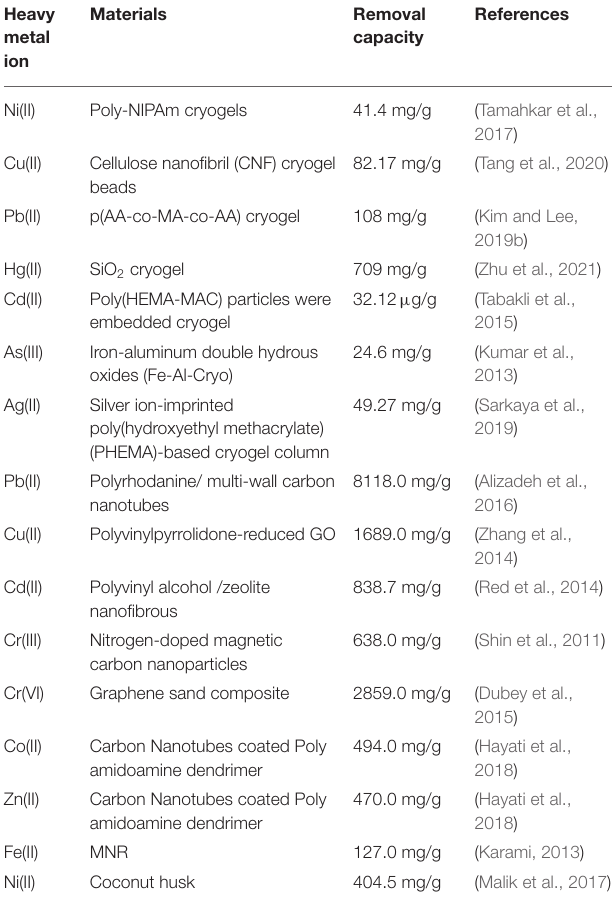
TABLE 3 | Comparison of heavy metal ion removal on cryogel and non-cryogel